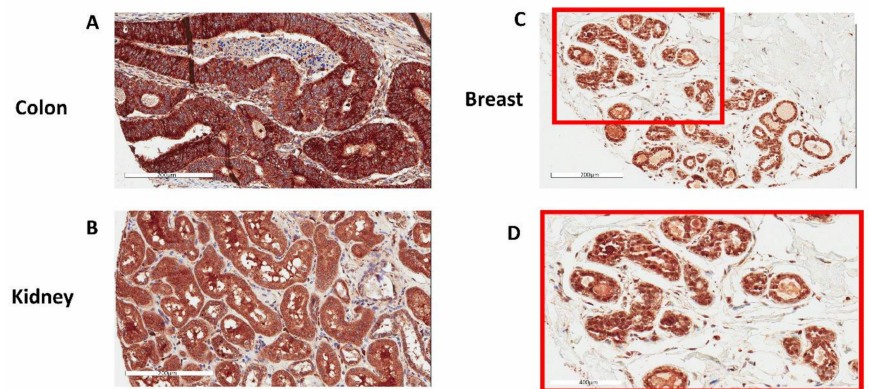
Figure 2. Representative images of GPX1 in human tissues immunostained with anti-GPX1 antibodies. ( A ) Colon, ( B ) Kidney, ( C , D ) Breast with panel ( D ) being a higher magnification of the inset in ( C ). 3.2. Nuclear Localization of GPX1 in Immortalized Human Prostate Cells but Not in Tumor-Derived Cell Lines